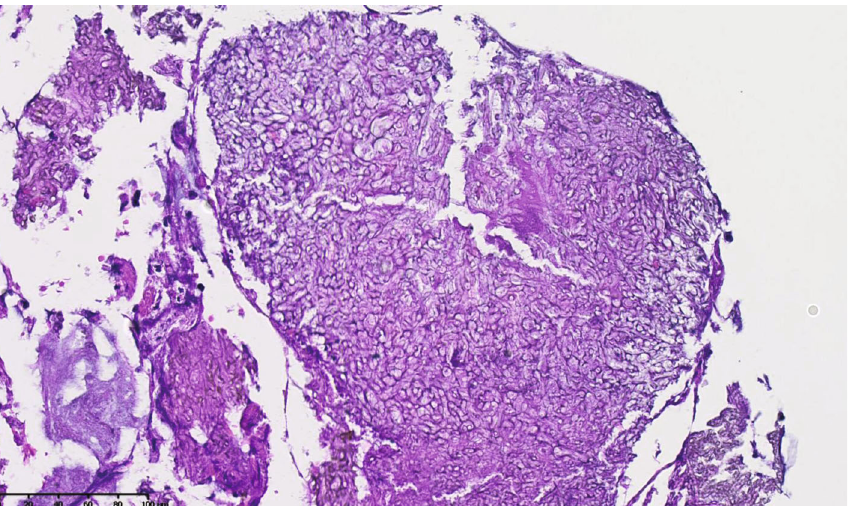
Figure 3: Histopathologic examination of the sinus material stained with periodic acid Schi ff stain (PAS) showing fungal hyphae morphologically consistent with Aspergillus